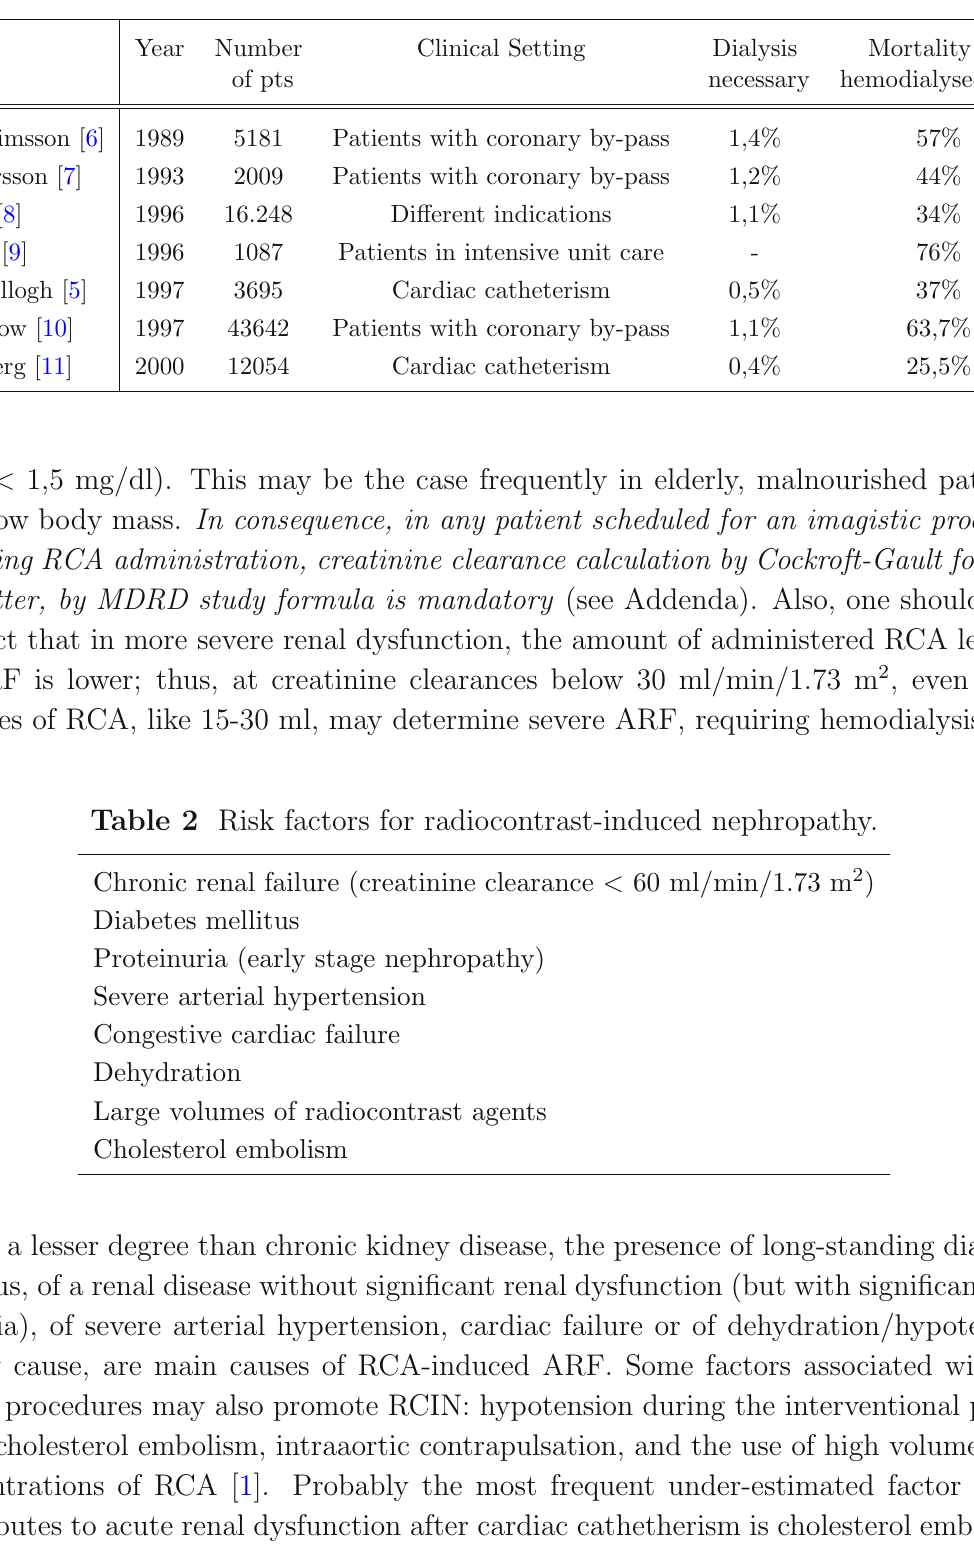
Table 1 The impact of radiocontrast agents nephrotoxicity on severity of acute renal failure and mortality.